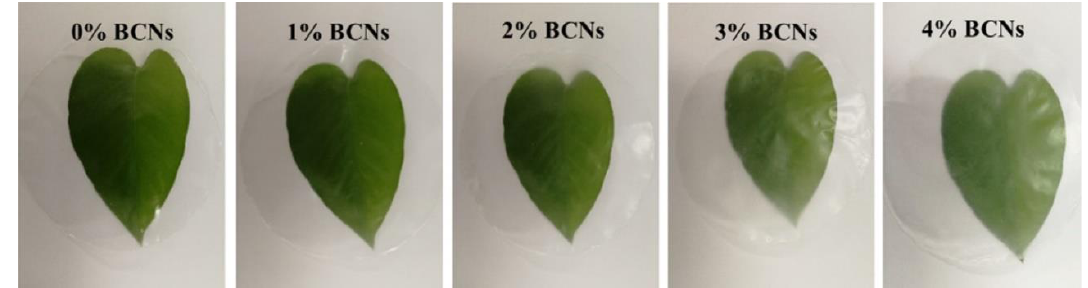
Figure 9. Light transmittance of konjac glucomannan (KG)-based edible films with different contents of bacterial cellulose nanofibers (BCNs) (0, 1%, 2%, 3% and 4%). Reproduced with permission from [37]. (Copyright 2020 Elsevier).